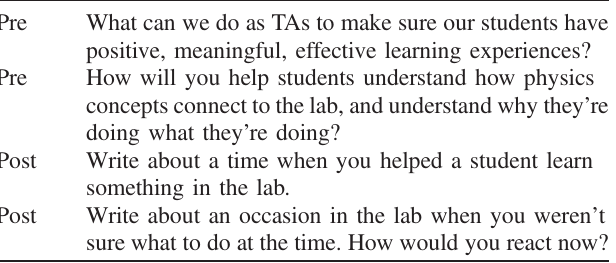
TABLE III. Writing prompts used to generate writing excerpts. Pre What can we do as TAs to make sure our students have positive, meaningful, effective learning experiences? concepts connect to the lab, and understand why they ’ re doing what they ’ re doing? something in the